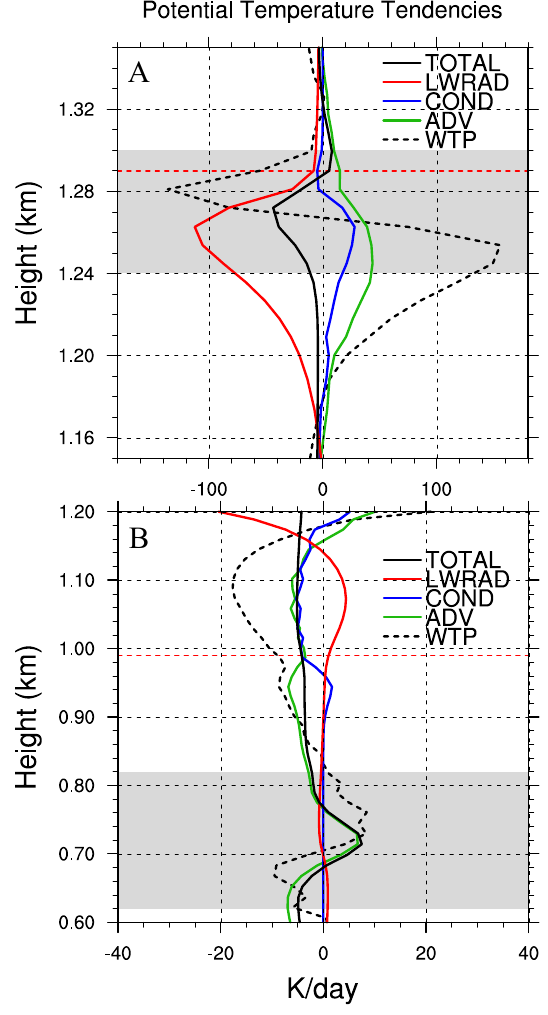
Fig. 9. Potential temperature tendencies averaged over the square box, in units of Kday − 1 . (A) The upper region of the mixed layer and cloud top entrainment zone. (B) Mixed layer and lower en- trainment zone. Tendencies plotted are total tendency (TOTAL, black), condensation/evaporation (COND, blue), longwave radia- tion (LWRAD, red), total advection (ADV, green), and vertical eddy advection (WTP, black dash). Tendencies are horizontally averaged across the square domain and then temporally averaged over the 20:00Z–21:29Z period. Note change in scale between (A) and (B) . Entrainment zones indicated with gray shading. Cloud layer top and base indicated by red dashed